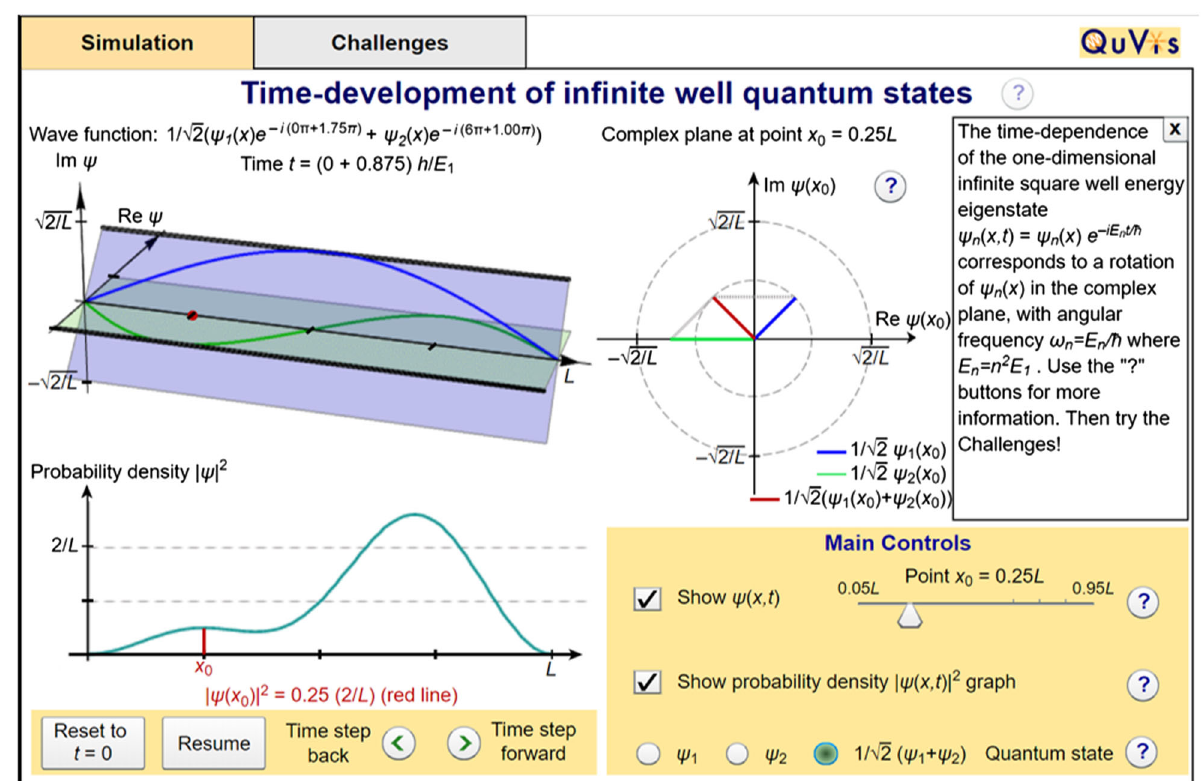
FIG. 1. A screenshot of the “ Time-development of infinite well quantum states ” simulation showing a superposition of the ground and first-excited states.